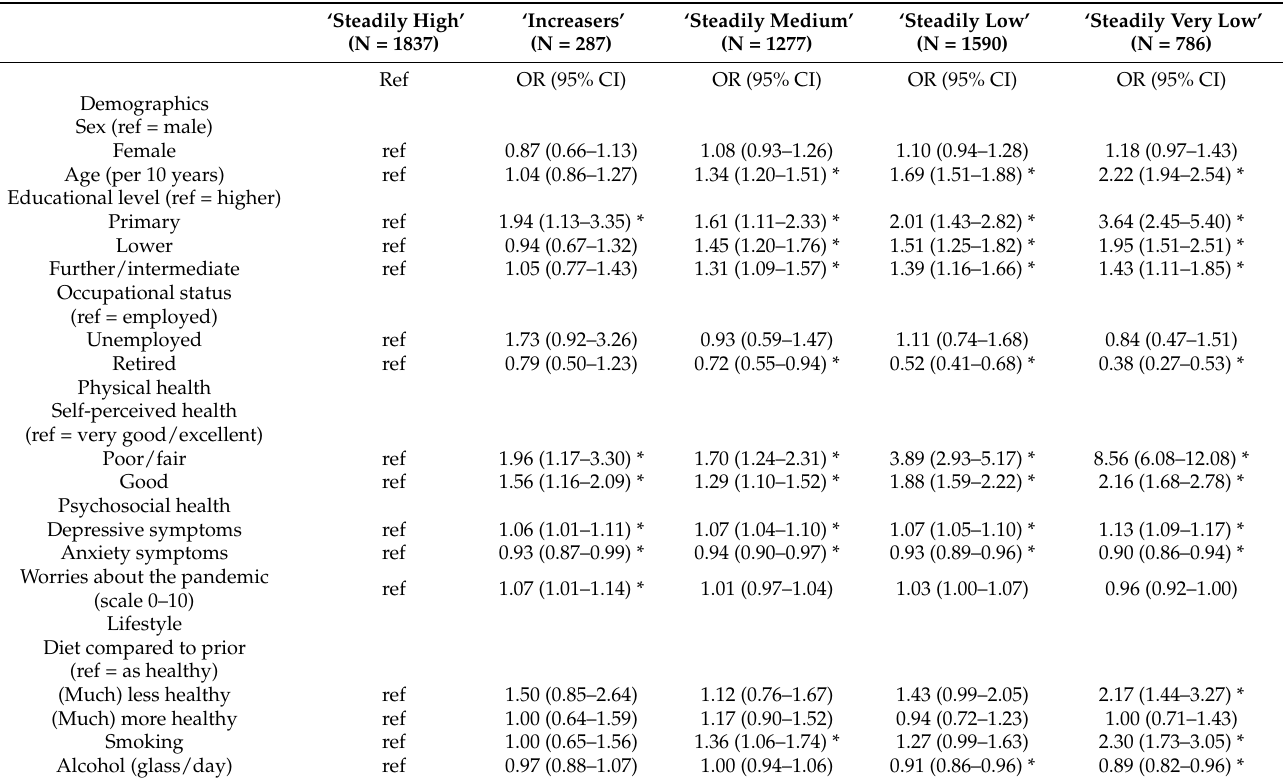
Table 3. Multivariate adjusted associations of potential determinants with the latent class of physical